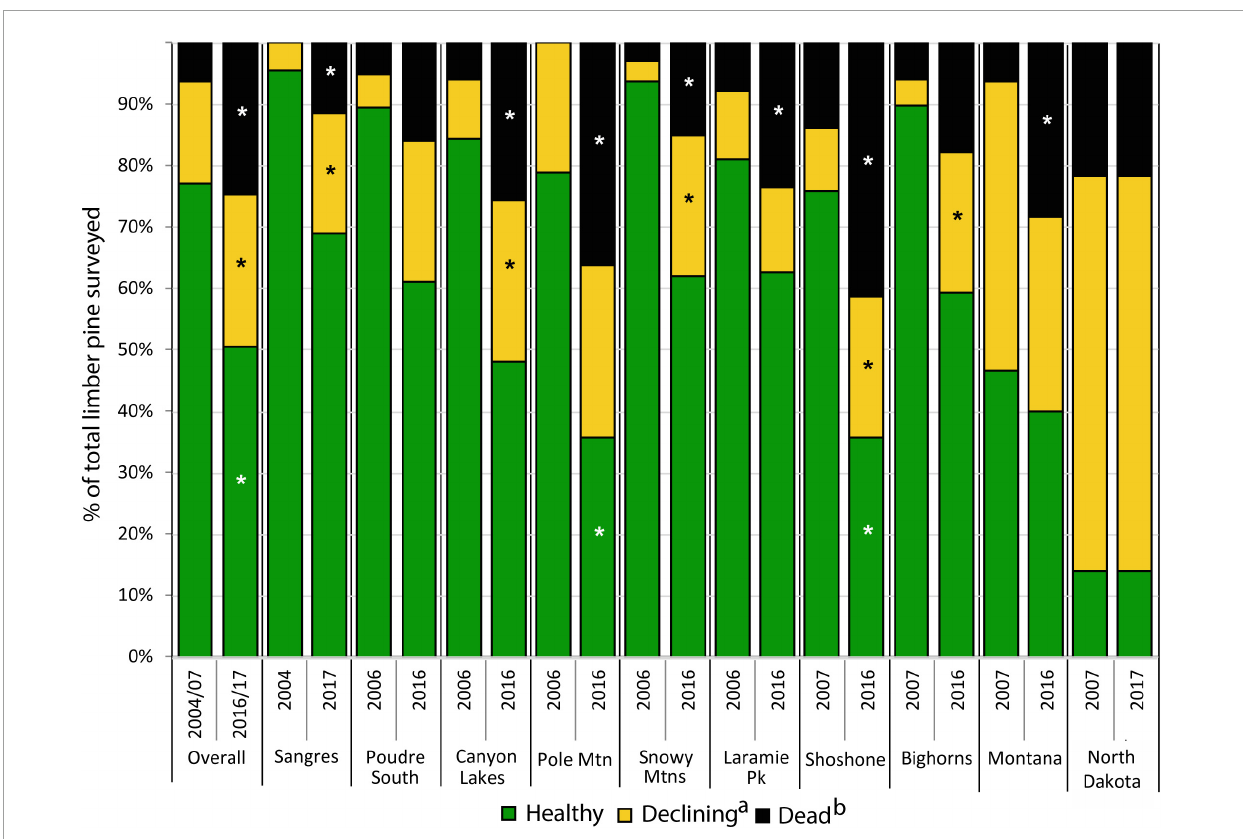
FIGURE3 Changes in the health status of limber pine trees ( > 1.37 m tall) from 2004–2007 to 2016–2017 overall and within 10 study areas (a) includes all trees classified as declining or dying; (b) includes all trees classified as recent dead and old dead. Dead trees not measured in the Sangre de Cristos in 2004–2007. Asterisks represent significant change ( P < 0.05) using paired t -test from 2004–2007 to 2016–2017 within study